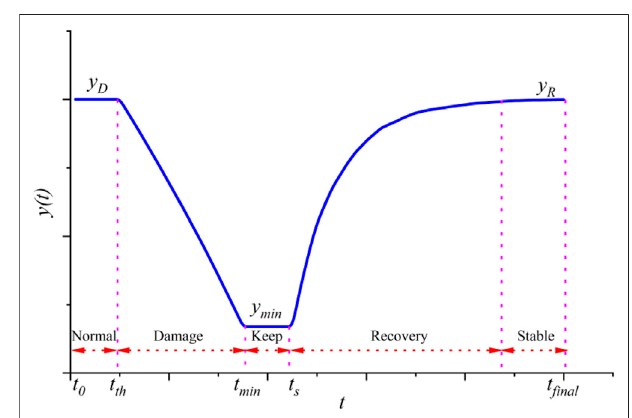
FIGURE 1 | Resilience change of UAV